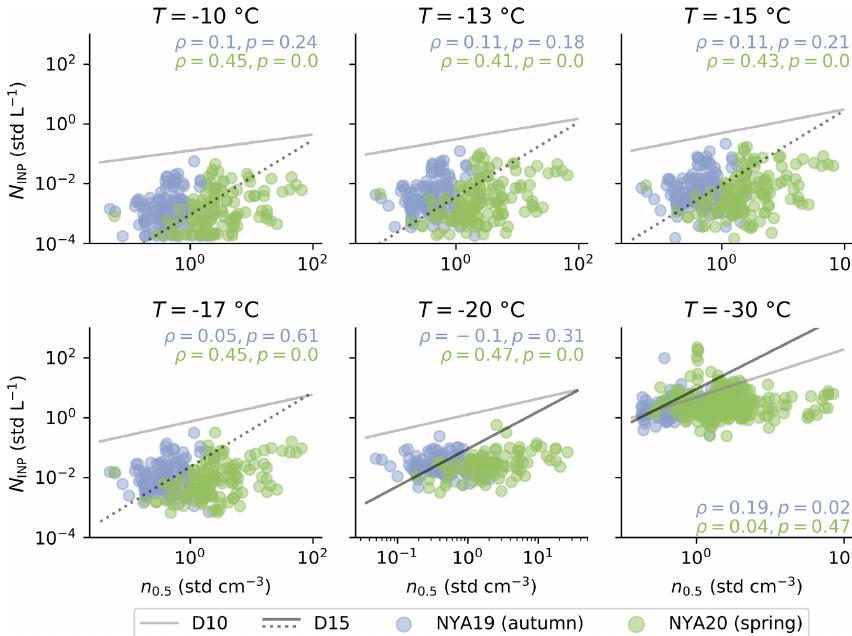
Figure 4. Observed INP concentration at selected temperatures as a function of particle number concentrations for particles larger than 0 . 5µm ( n 0 . 5 ) during sampling in the autumn (violet) and spring (green) campaign. The Spearman’s rank coefficient ( ρ ) and p value are given for each plot. Predicted INP concentration by DeMott et al. (2010) (D10) and DeMott et al. (2015) (D15) are presented in solid gray and black, respectively. Predictions of the D15 parameterization outside of the applicable temperature range ( T > − 20 ◦ C) are indicated as dashed lines.